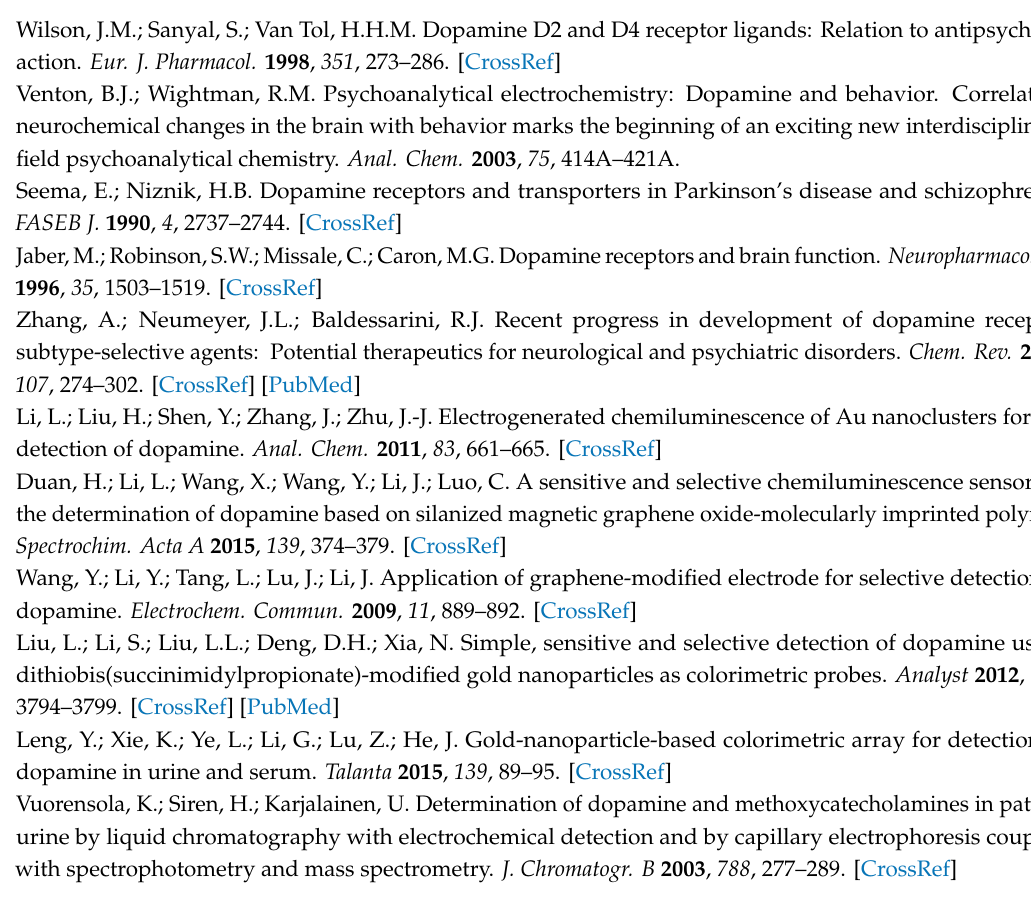
Figure S1: EDX spectrum of CdTe 0.5 S 0.5 / ZnS@MIP